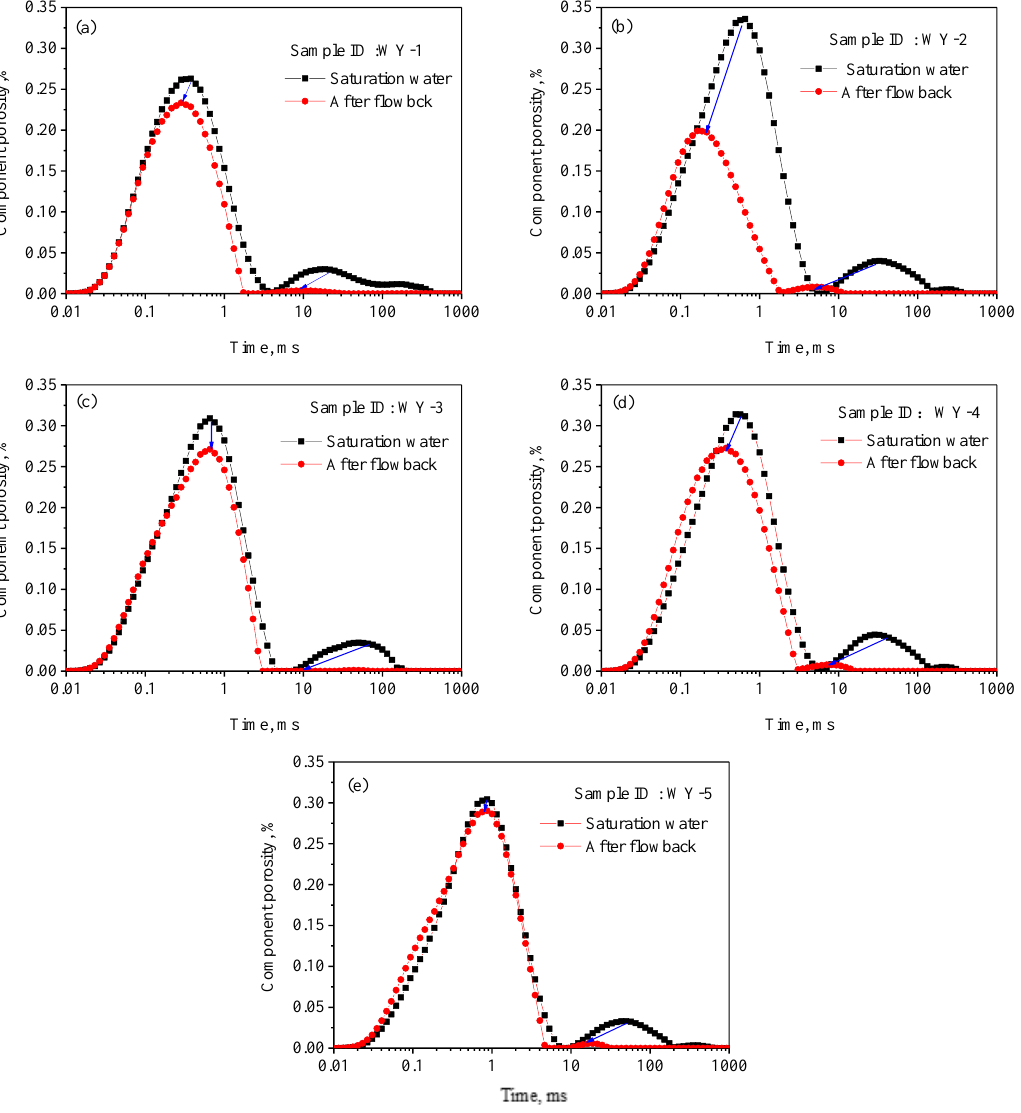
Figure 8. Comparison map of T 2 spectra of five shale samples after saturated water and flowback (After flowback of 5 samples, the right peak disappeared obviously and the leaf peak moved down or left).